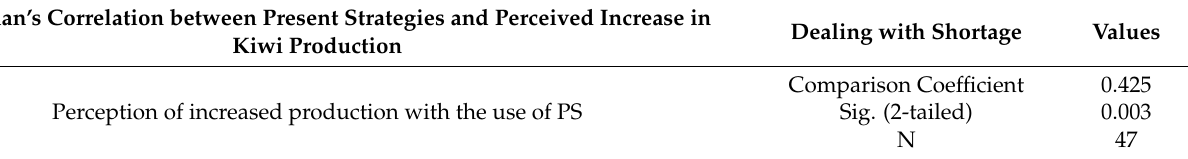
Table 3. Spearman’s correlation between present strategies and perceived increase in kiwi production. Spearman’s Correlation between Present Strategies and Perceived Increase in Kiwi Production Perception of increased production with the use of PS